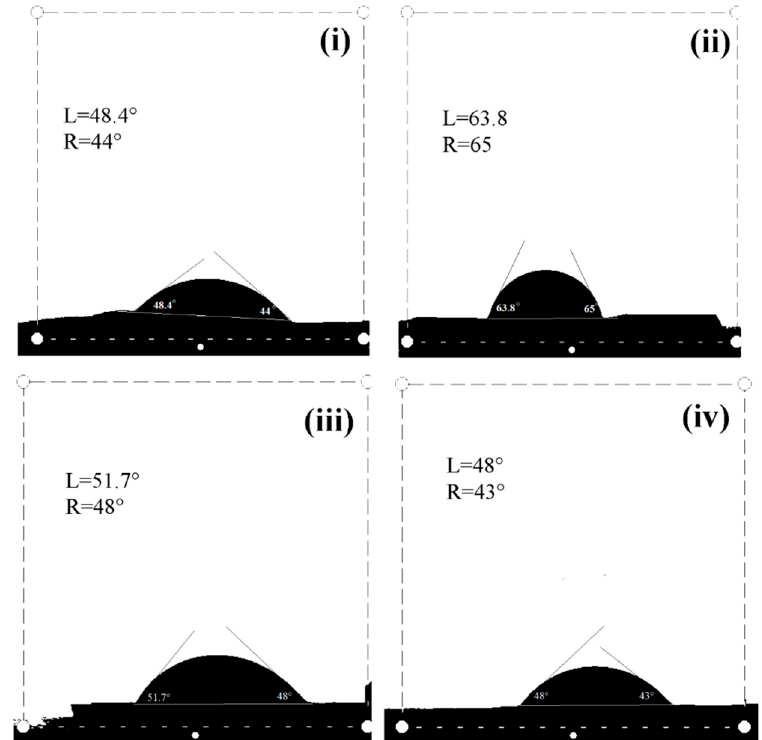
Figure 4. Contact angle measurements of ( i ) NRL film (control), and composite films made of NRL and NOCNF with varying concentration of NOCNF ( ii ) 0.1 wt. %, ( iii ) 0.2 wt. %, ( iv ) 0.4 wt.%.